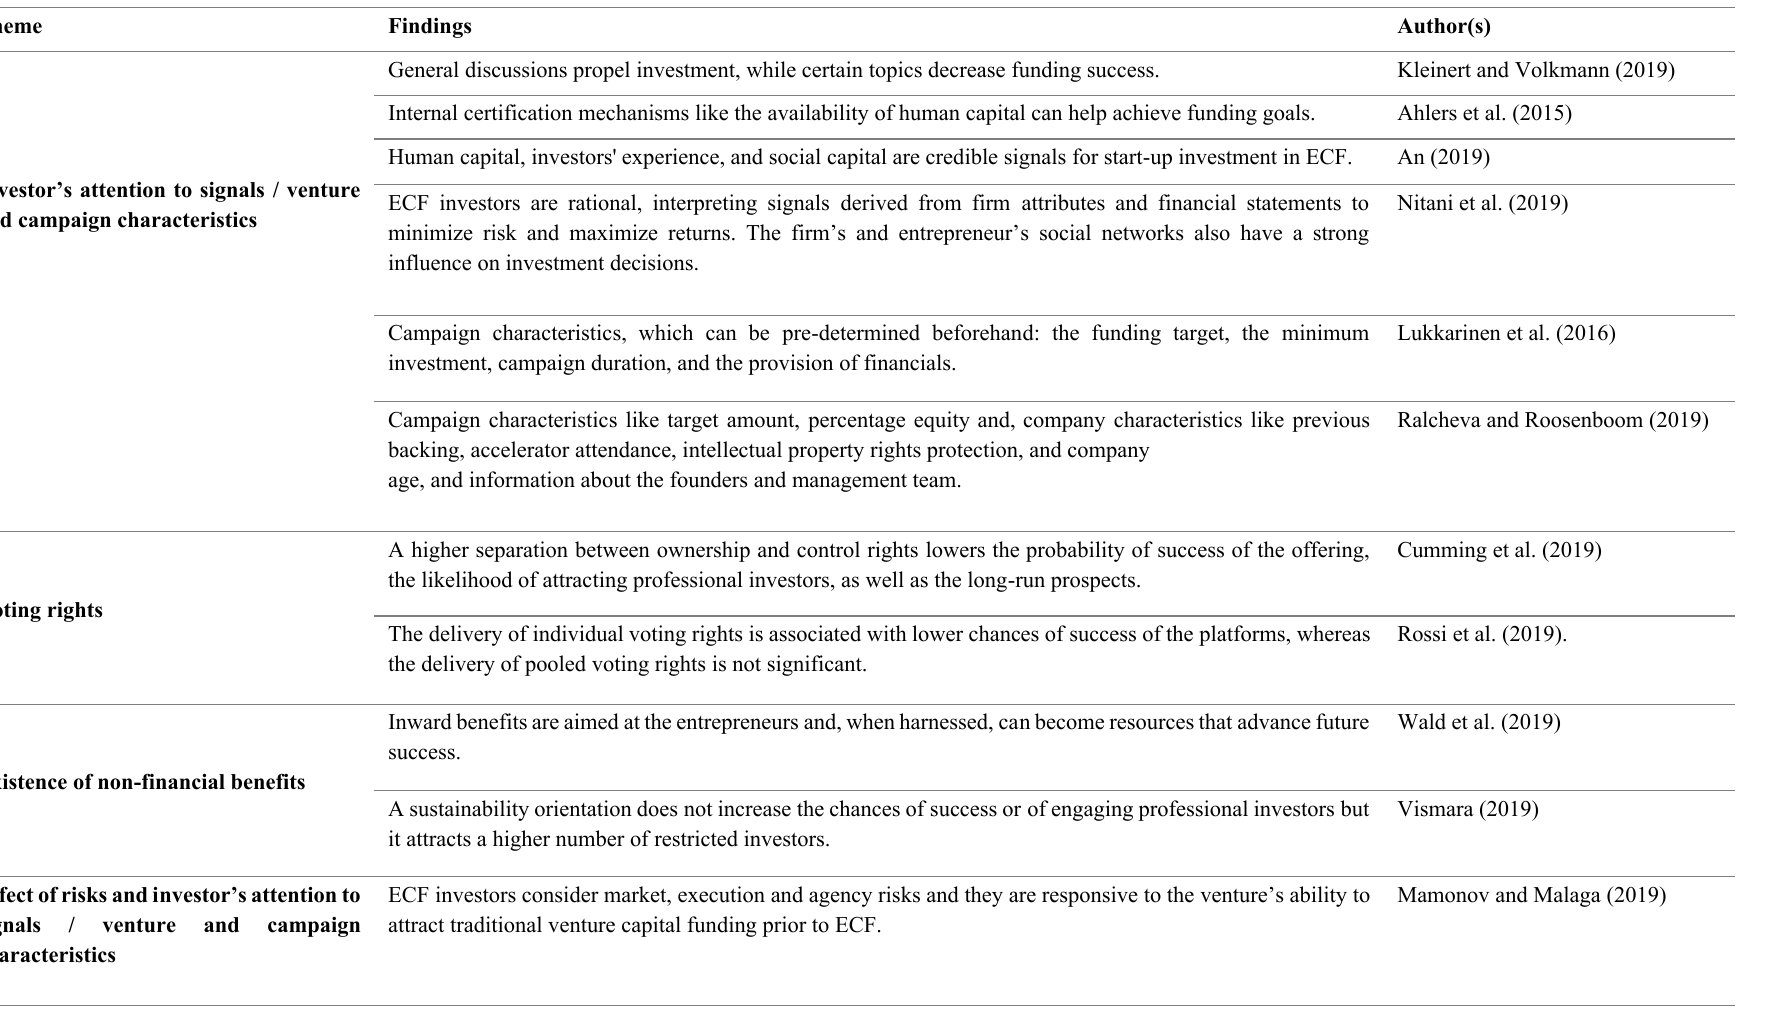
Table 2: Emerging themes in relation to ECF and